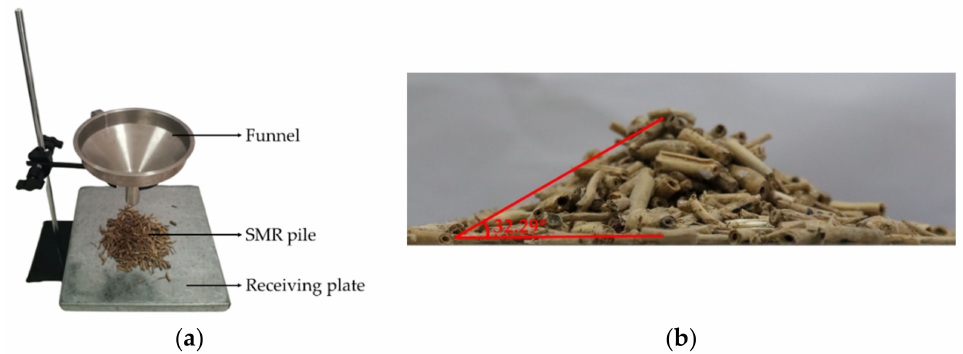
Figure 8. Measurement of physical AOR of SMR. ( a ) Test device; and ( b ) AOR value.